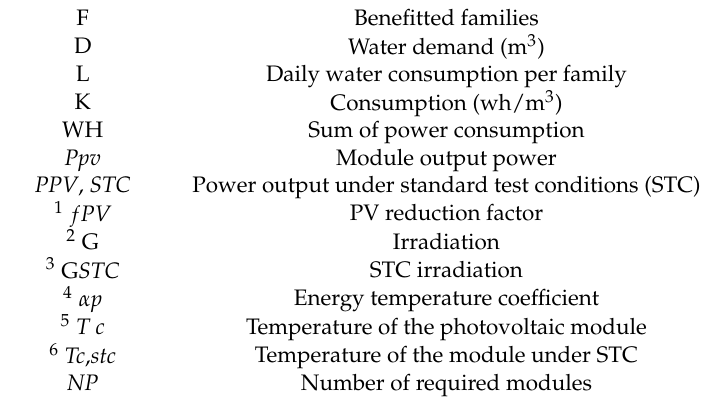
Table 1. Parameters required to calculate PVSS